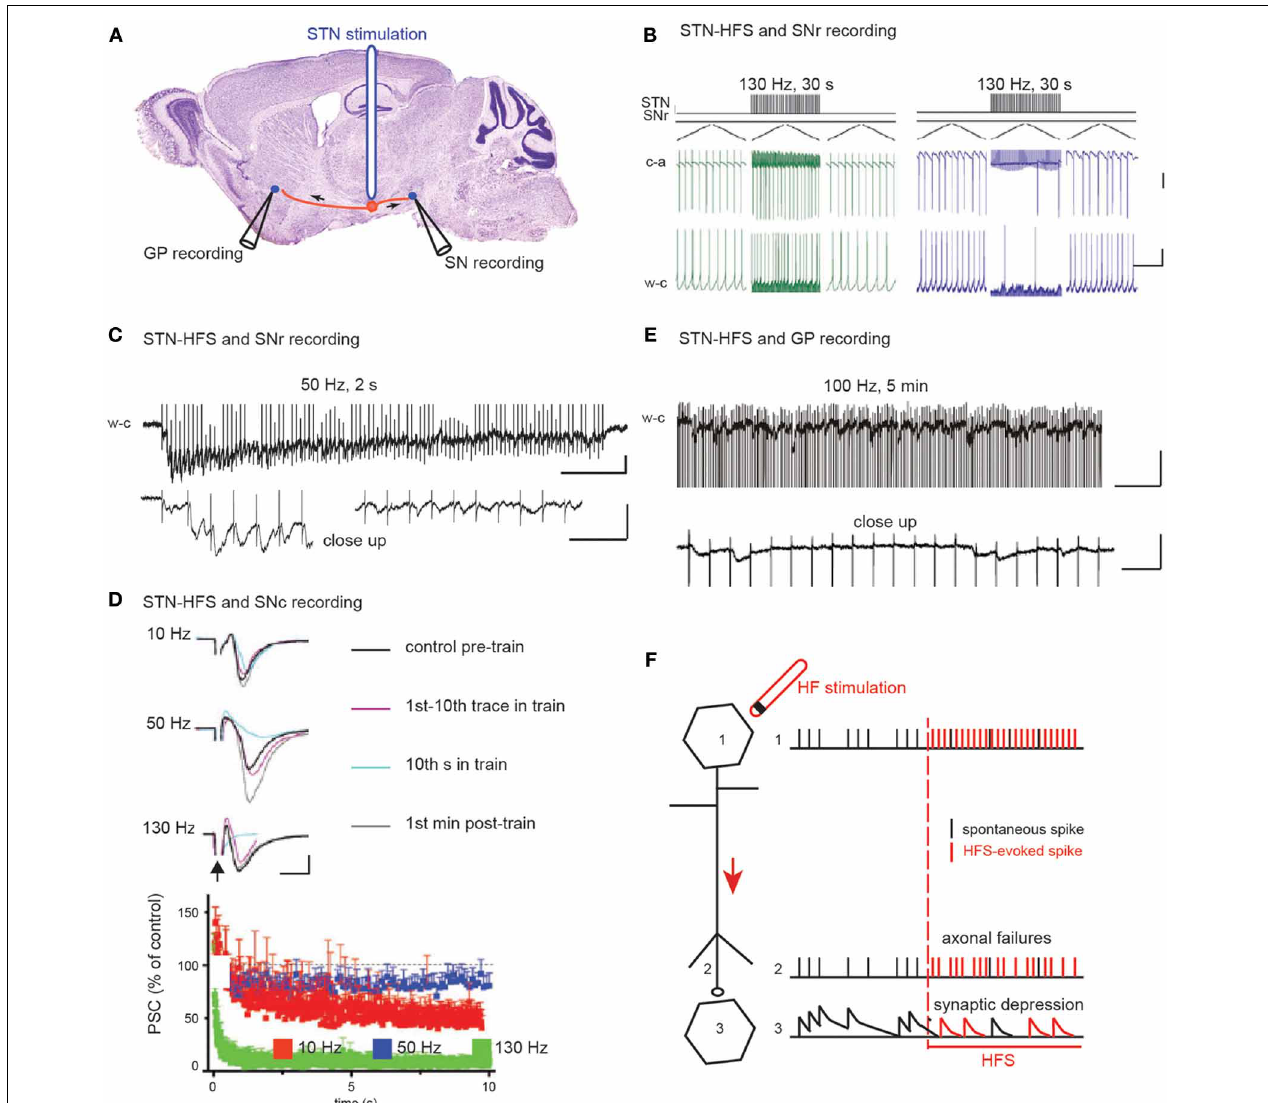
FIGURE 2 | The two hypotheses on the effect of STN HFS-evoked orthodromic spikes on the activity of substantia nigra and pallidal neurons. (A) Schematic illustration of the experimental design showing the stimulation and recording sites. (B) HFS-evoked orthodromic spikes in STN axons evoke excitatory (left) and inhibitory (right) responses in SNr neurons recorded in cell-attached (c-a) or whole-cell (w-c) configuration in voltage (top) or current (bottom) clamp mode. Scale bars: 100pA top, 5mV bottom, 400ms. Adapted from Bosch et al. (2011). (C–E) HFS-evoked orthodromic